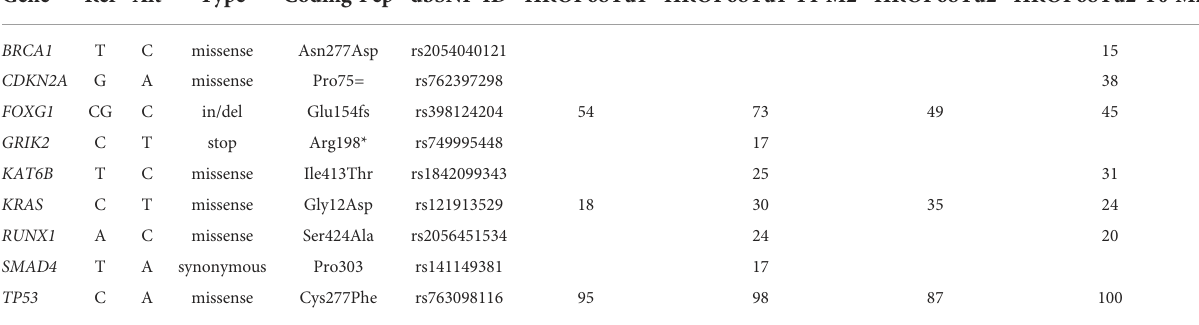
TABLE 1 Mutational pro fi ling of the HROP68 primary tumor (HROP68Tu1), HROP68 recurrent tumor (HROP68Tu2), and their PDX models (HROP68Tu1 T1 M2 and HROP68Tu2 T0 M2).